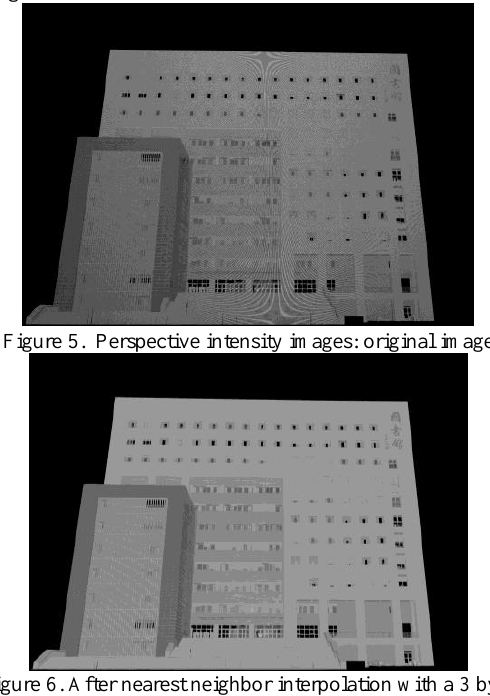
Figure 6. After nearest neighbor interpolation with a 3 by 3 window